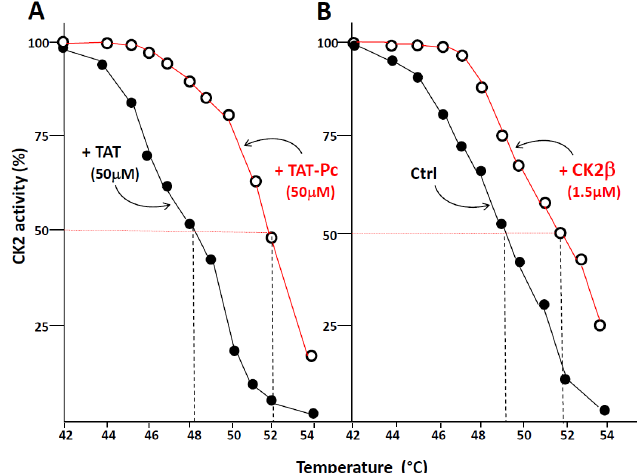
Figure 5. Thermal shift assay in cell lysates. CK2β-depleted MCF-10A cell lysates were treated with 50 µM TAT or TAT-Pc 13 ( A ), or with PBS (Phosphate-buffered saline) or CK2β ( B ) for 30 min at room temperature. The respective lysates were divided into 20 µL aliquots and heated individually at different temperatures for 3 min. After centrifugation, the supernatants were assayed for CK2 activity with the CK2β-independent peptide substrate. Representative data shown from two independent experiments in duplicate.